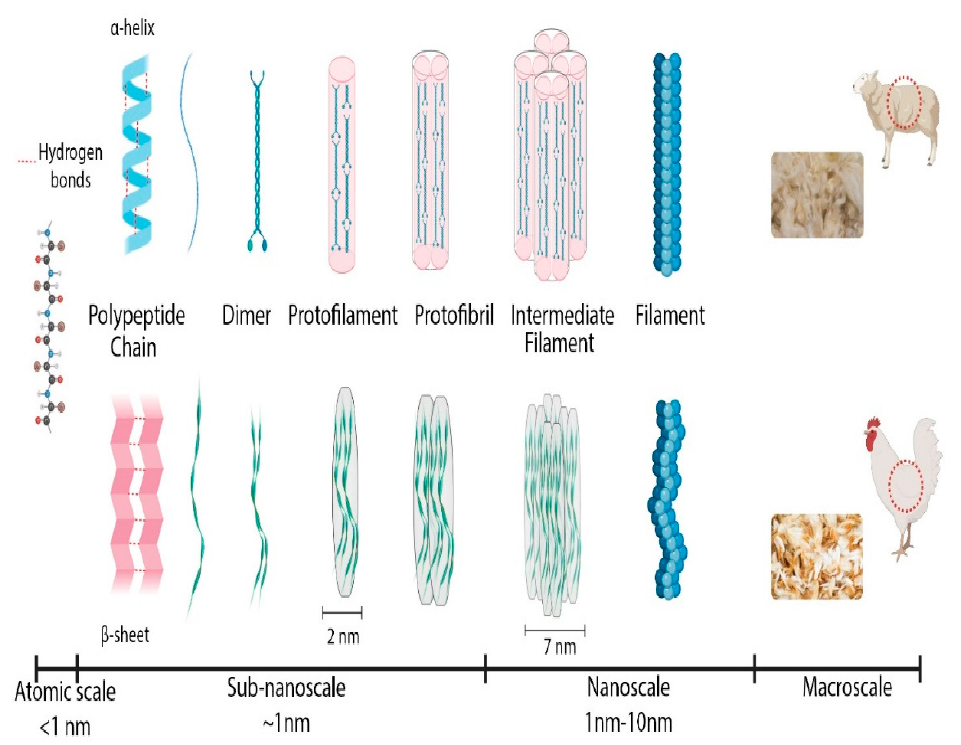
Figure 1. Schematic of the hierarchical structure of keratin from nanoscale to centimeter scale for wool and feathers (original drawing by S.M.).